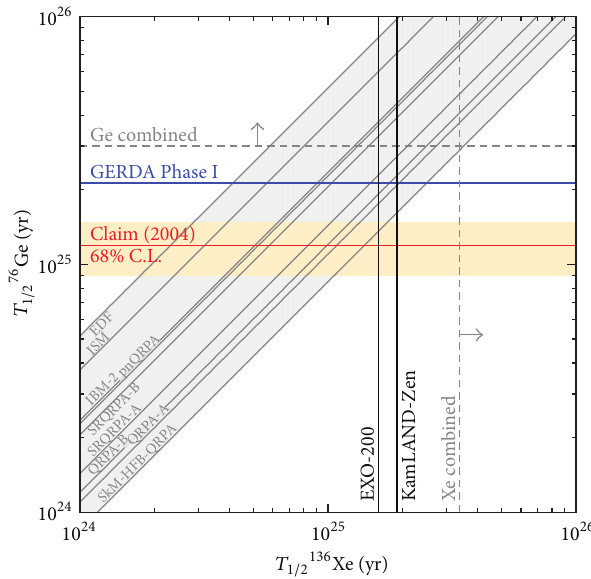
Figure 15: Limits at 90% C.L. on 𝑇 0 ] 1/2 for 76 Ge (Gerda Phase I alone and Gerda Phase I, Igex and HdM combined together [33]) and for 136 Xe [21, 22]. The signal claim for 76 Ge from [19] is also shown. The lines in the shaded gray band are the predictions for the correlation betweenthehalf-livesobtainedin 136 Xeandin 76 Geusingaselection of different nuclear matrix element calculations taken from [64]. From